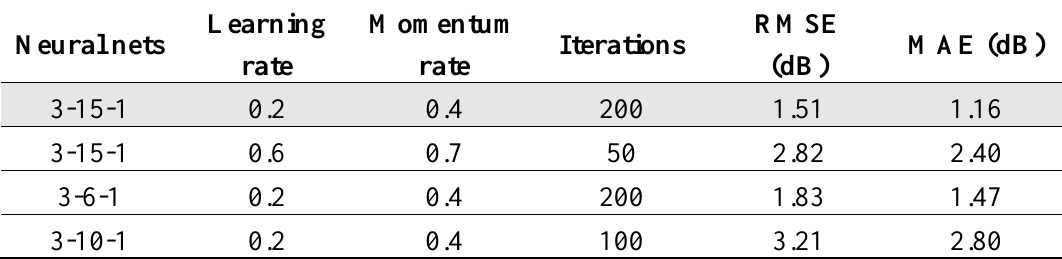
Table 1. The comparison of ANN models for spatial interpolation of observed points at 100 cm from the floor. MAE, mean after all errors made positive and RMSE, square root of mean squared predicted electromagnetic power minus observed electromagnetic